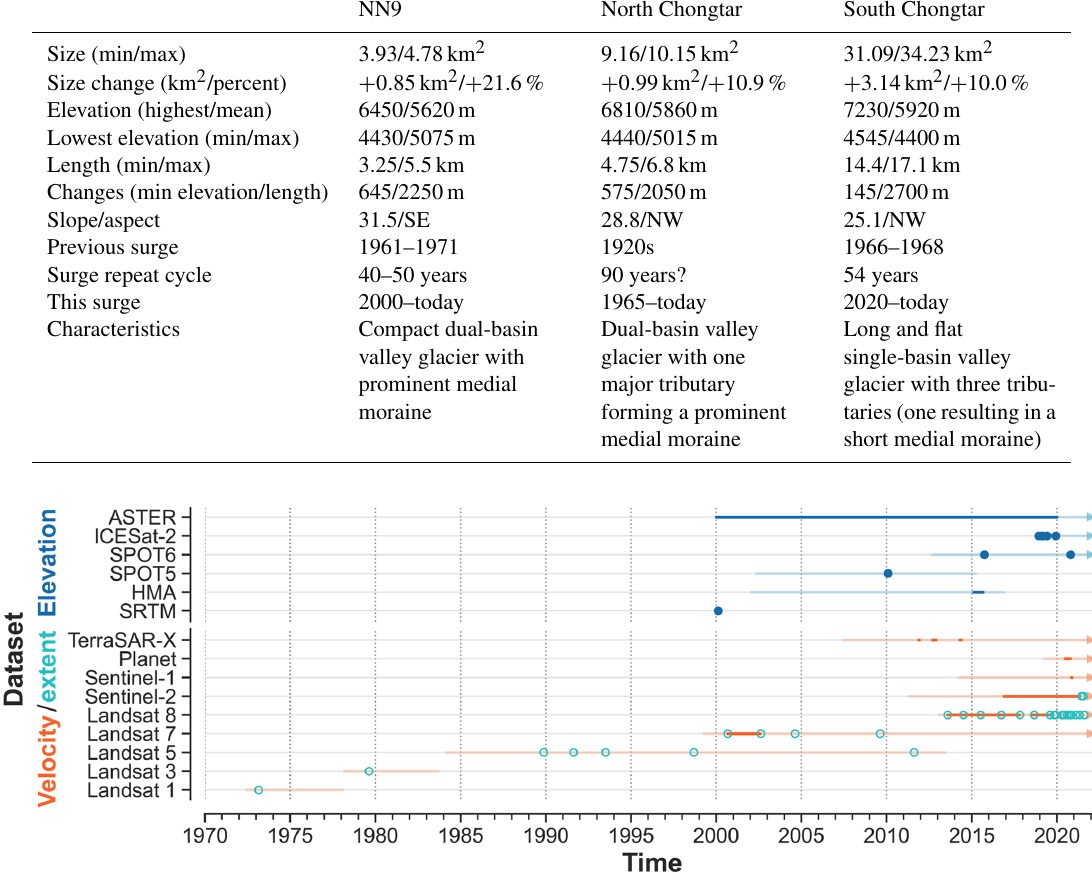
Figure 2. Timeline of the temporal coverage of the satellite sensors used (light line) and dates and time series selected for the analysis (lines or dots). Lines and dots in dark blue indicate the elevation change analysis, orange lines the velocity analysis, and green dots the glacier